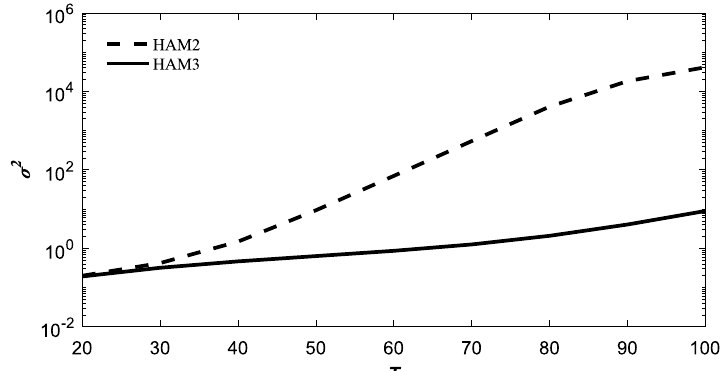
Fig. 6 Average variances of generated data based on HAM2 and HAM3 for a certain number of periods T from 20 to 100. Every period specification is run for 10,000 simulations. HAM2: x t = 1 R ∗ ( 0.908 n f , t + 1.113 n c , t ) x t − 1 + ǫ t , ǫ t ∼ N ( 0,0.048 ) ; HAM3: